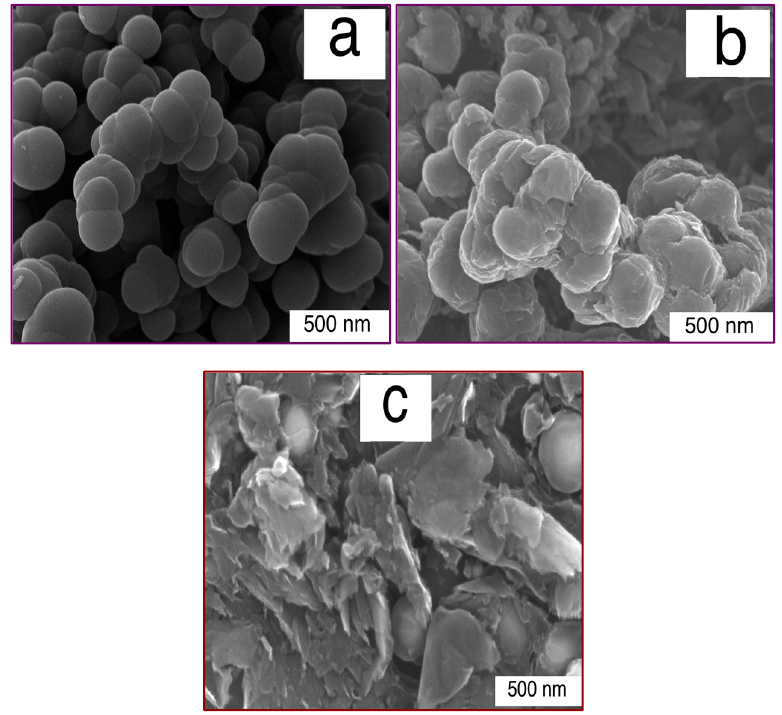
Figure 1. SEM images of ( a ) CNS (carbon nanospheres); ( b ) CNS-FLG (Carbon nanosphere-few layer graphene) and ( c ) CNS-MLG (Carbon nanosphere-multi layer graphene). graphene) and ( c ) CNS-MLG (Carbon nanosphere-multi layer